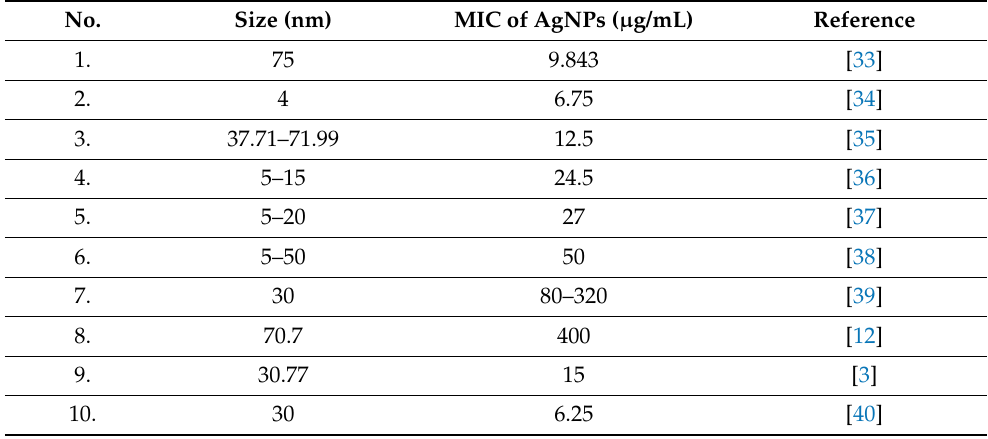
Table 4. Selected studies on the antibacterial activity of silver nanoparticles to E. coli .